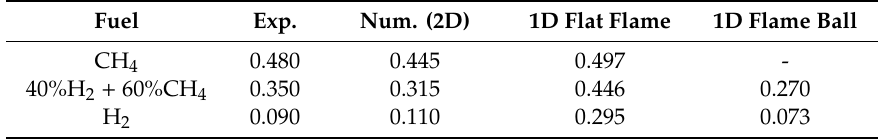
Table 7. Prediction of lower flammability limit (LFL) (equivalent ratio) for different types of flame with different fuel compositions. The numerical simulation considered thermal radiation Reproduced in Ref. [22], The Combustion Institute: 2017.